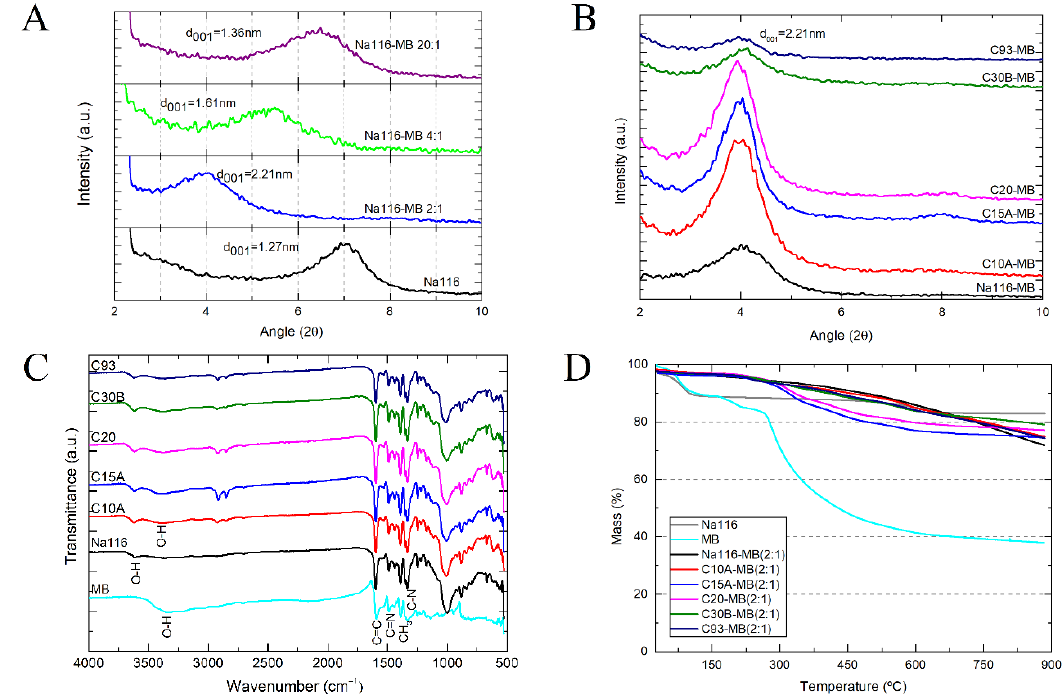
Figure 9. Clay’s final basal spacing after MB encapsulation: Na116 clay:MB weight ratio from 2:1 to 20:1 prepared in water ( A ), and all OMMT clays with a weight ratio of 2:1 prepared in ethanol ( B , C ) MB and clay’s FTIR spectra after MB encapsulation, with a clay:MB weight ratio of 2:1, prepared in water for Na116 clay and ethanol for all OMMT clay; ( D ) Clay–MB hybrid degradation stages as a function of temperature.